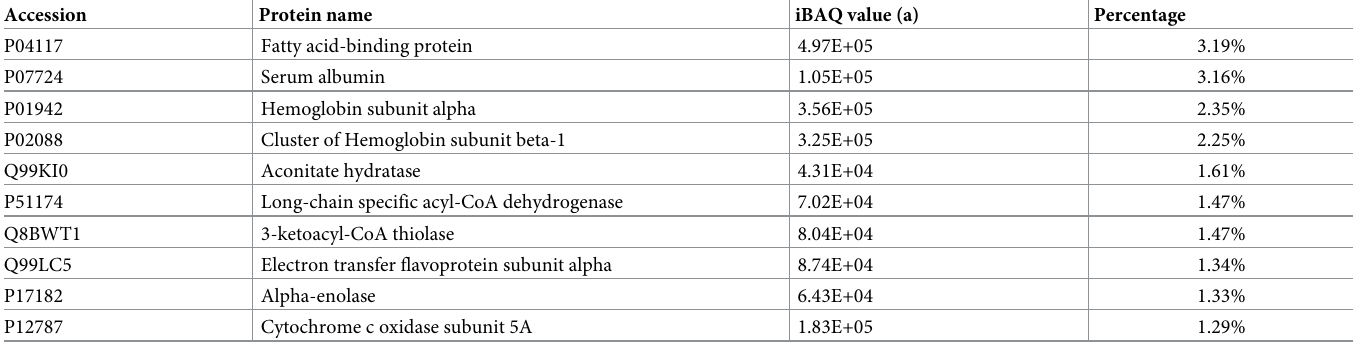
Table 2. The top ten abundant proteins in the mouse BAT